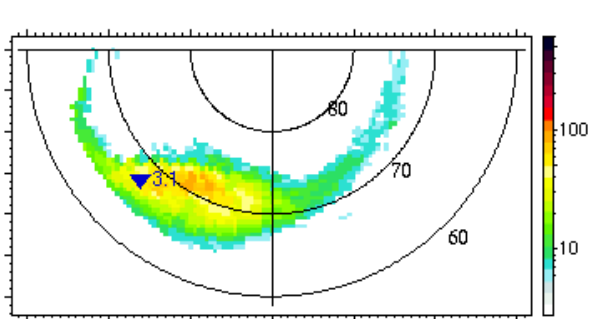
Fig. 6. Polar UVI data for 9 December 1996. The Interball Auro- ral Probe footpoint is marked with a triangle. Interball is making measurements in the auroral bulge. G. Parks and CDAWeb are ac- knowledged.